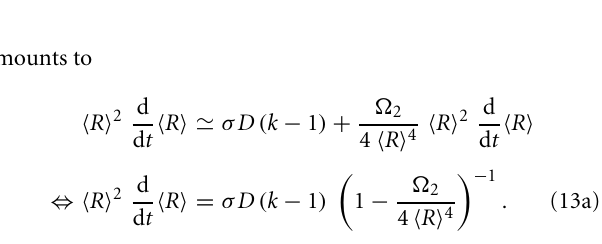
(cid:2) R (cid:3) for different values of k , as FIGURE 4 | Evolution of (cid:2) R (cid:3) 2 d d t indicated in the legend. The data is obtained by evaluating Equation (9b) for our numerical data. As predicted by Equation (10) it always approaches σ D ( k − 1 ) for large t . In the inset we show the mismatch of the numerical data and the improved prediction, Equation